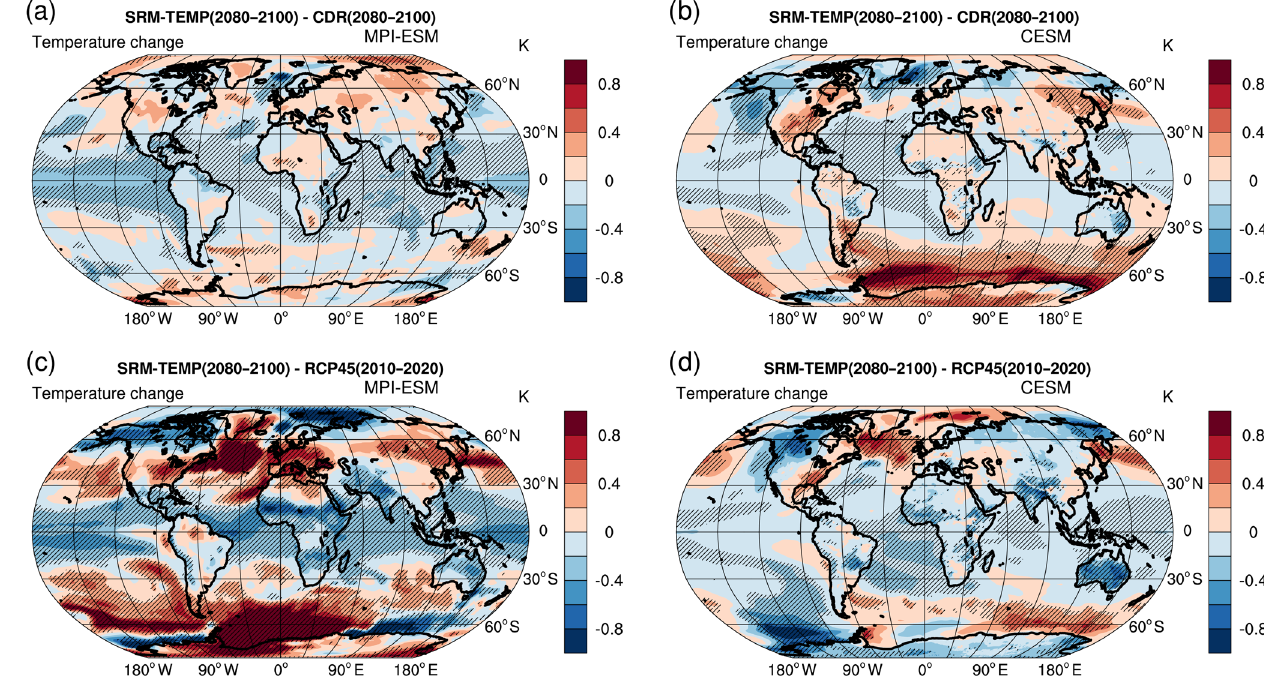
Figure 9. Differences in regional temperature patterns between the SRM-TEMP and CDR scenarios for the years 2080–2100 in (a) MPI- ESM and (b) CESM. Also shown are the temperature differences between the SRM-TEMP scenario for the years 2080–2100 and present- day climate (RCP4.5, years 2010–2020) in (c) MPI-ESM and (d) CESM. Hatching indicates regions where the temperature change is statistically significant at the 95% level, with significance levels estimated using a Student’s paired t test (sample of 20 yearly mean values for three ensemble